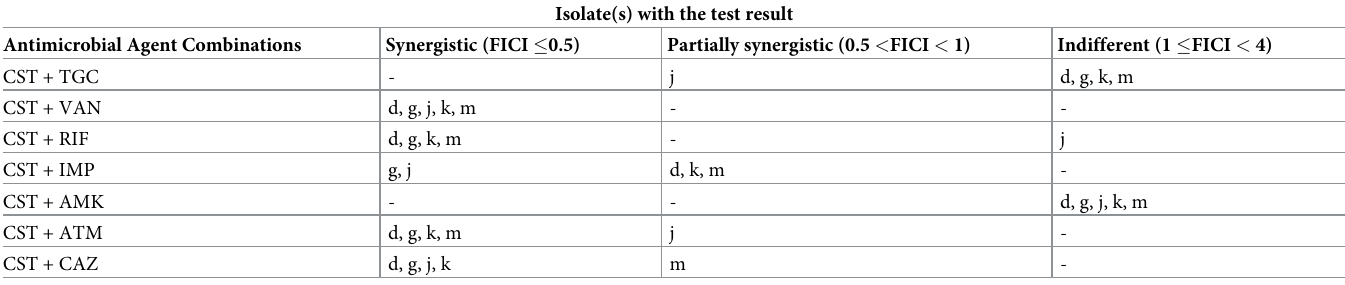
Isolate(s) with the test result